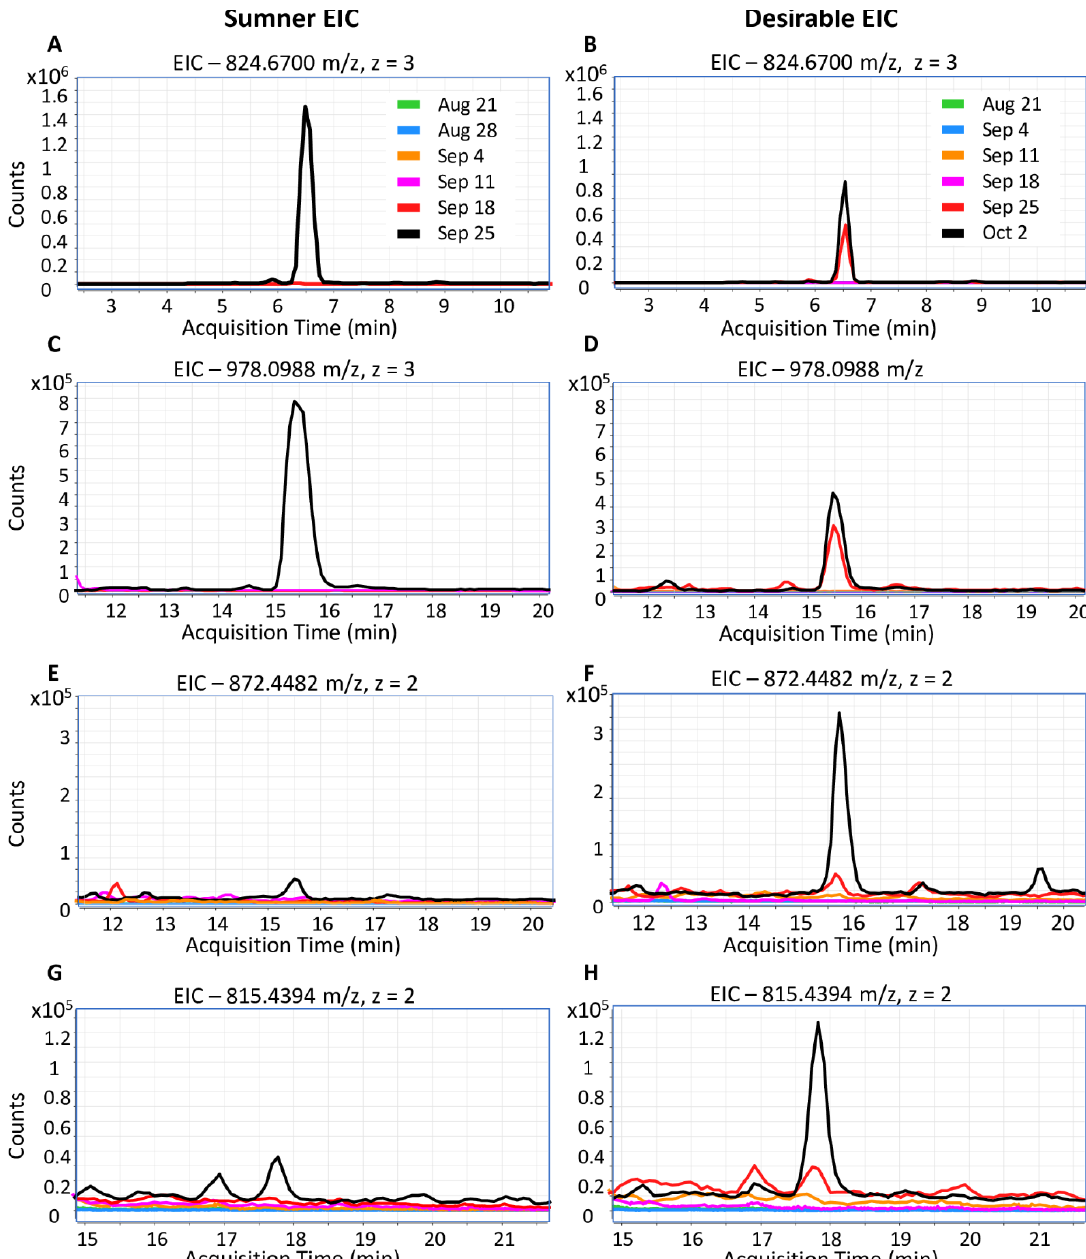
Figure 5. Extracted ion chromatograms of Car i 1 and Car i 2 peptides. ( A , C , E , G ) Pecan allergens in Sumner. ( B , D , F , H ) Pecan allergens in Desirable. ( A , B ) Car i 1 peptide. QCCQQLSQMEEQCQCEGLR, 824.6703 m / z , z = 3, RT = 6.5 min. ( C , D ) Car i 1 peptide. QQQQEEGIRGEEMEEMVQCASDLPK (with N-terminal glutamine cyclization to pyroglutamate), 978.0988 m / z , z = 3, RT = 15.5 min. ( E , F ) Car i 2 peptide. NFLAGQNNIINQLER, 872.4482 m / z , z = 2, RT = 15.8 min. ( G , H ) Car i 2 peptide. VFSNDILVAALNTPR, 815.4394 m / z , z = 2, RT = 17.8 min.